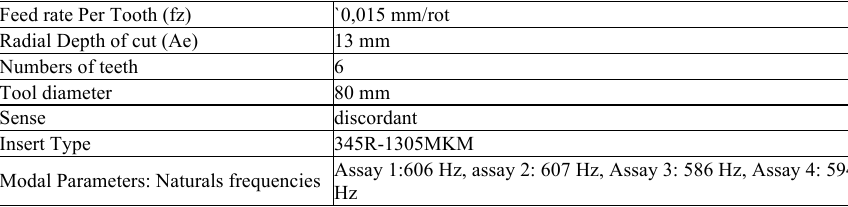
Table 2. Cutting parameters kept